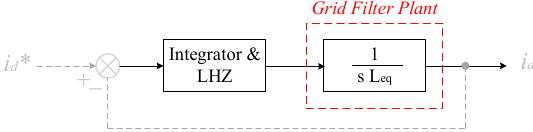
Figure 17. Step 3 of the loop-shape design technique.